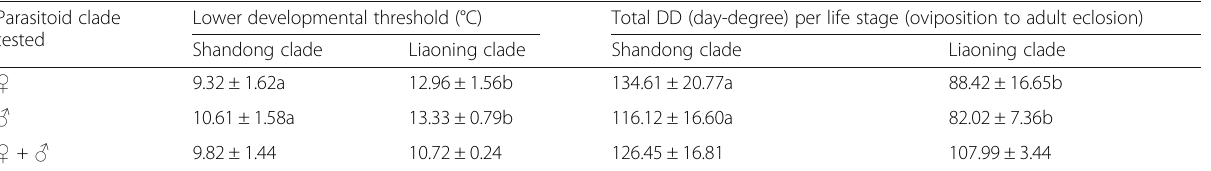
Table 3 The lower developmental thresholds and total day-degree of non-overwintering generation of Aphelinus mali for two gen- etic clades in China Parasitoid clade tested